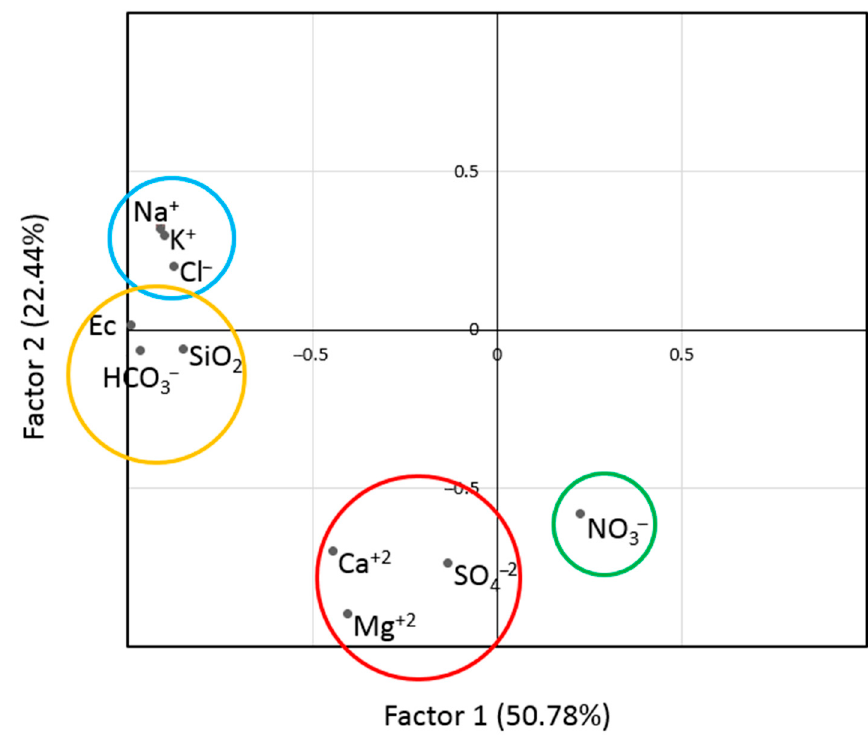
Figure 6. Plot of the principal component analysis results for major elements.